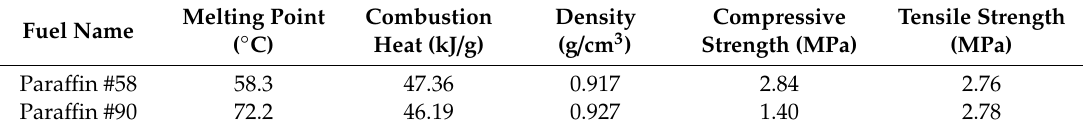
Table 4. Physical properties of the tested kinds of para ffi n.